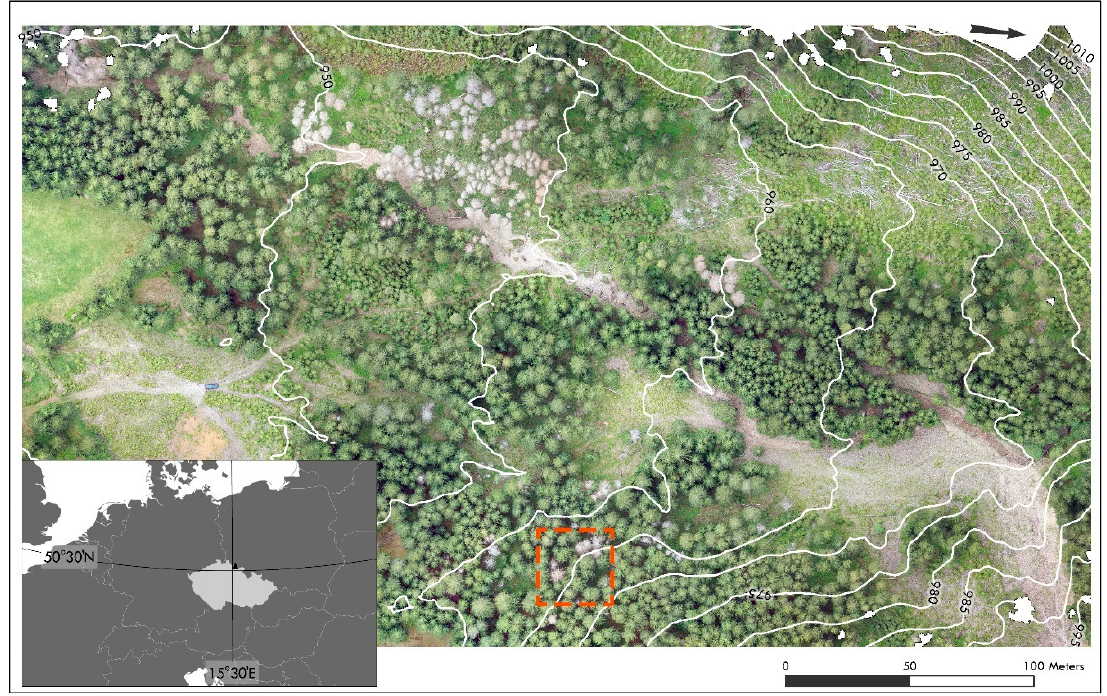
Figure 1. The location of the study area (50°30'N 15°30'E) in the central Europe and the extent of the study site; the red square denotes the borders of Figure 2. The background image represents the true color composite for the first sensing period (15 June).